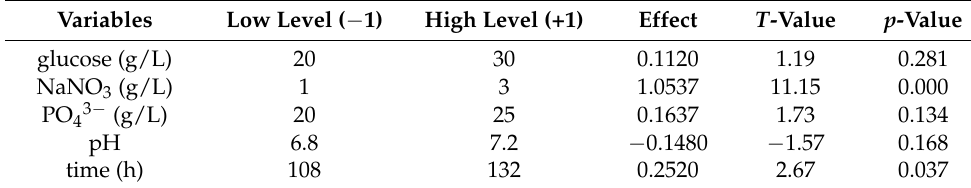
Table 1. Plackett-Burman (PB) design for screening significant variables.